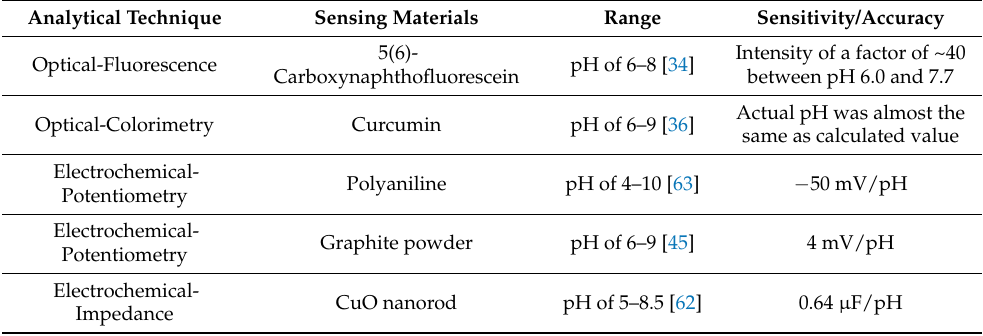
Table 1. Comparison of different wearable pH sensors based on different sensing